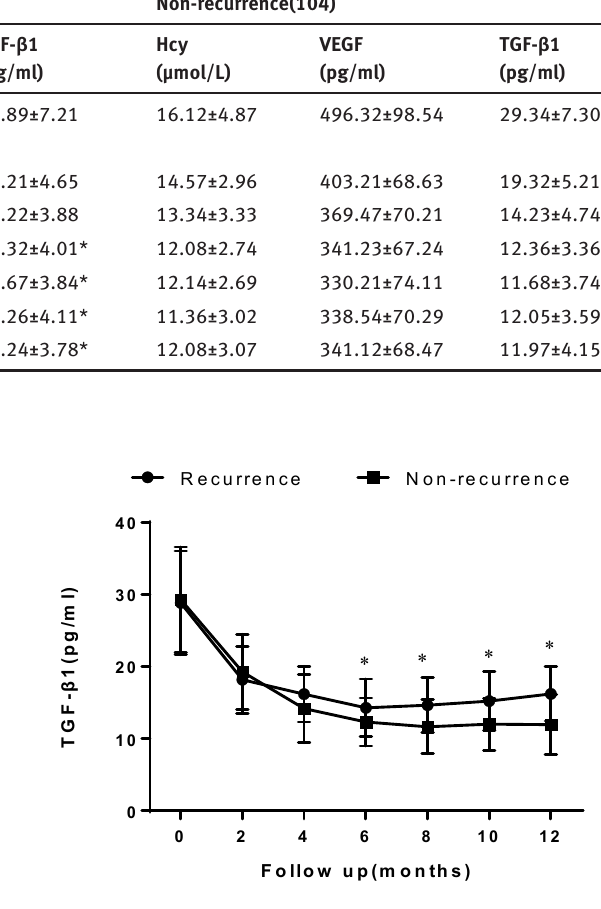
Figure 3: Serum TGF-β1 dynamic changes in recurrent and non- recurrent colorectal cancer patients prior and post-operation (0 month means prior